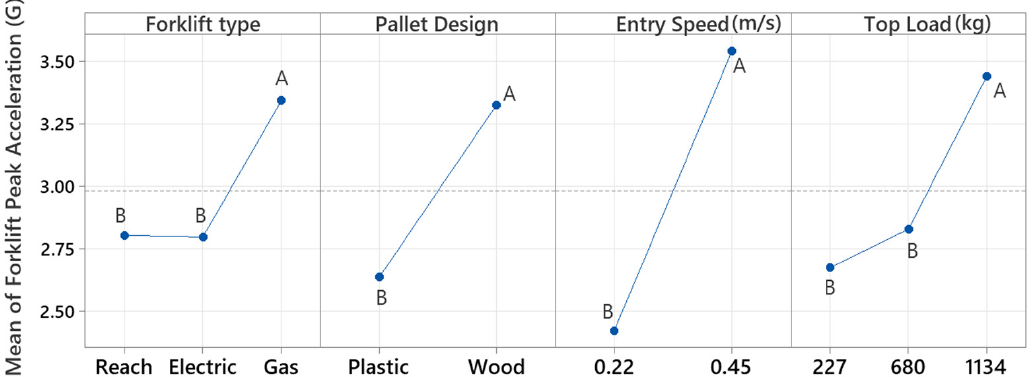
Figure 4. Main effects plot for forklift Peak Acceleration response. Tukey pairwise comparison indicates means that do not share a letter are significantly different at α = 0.05.